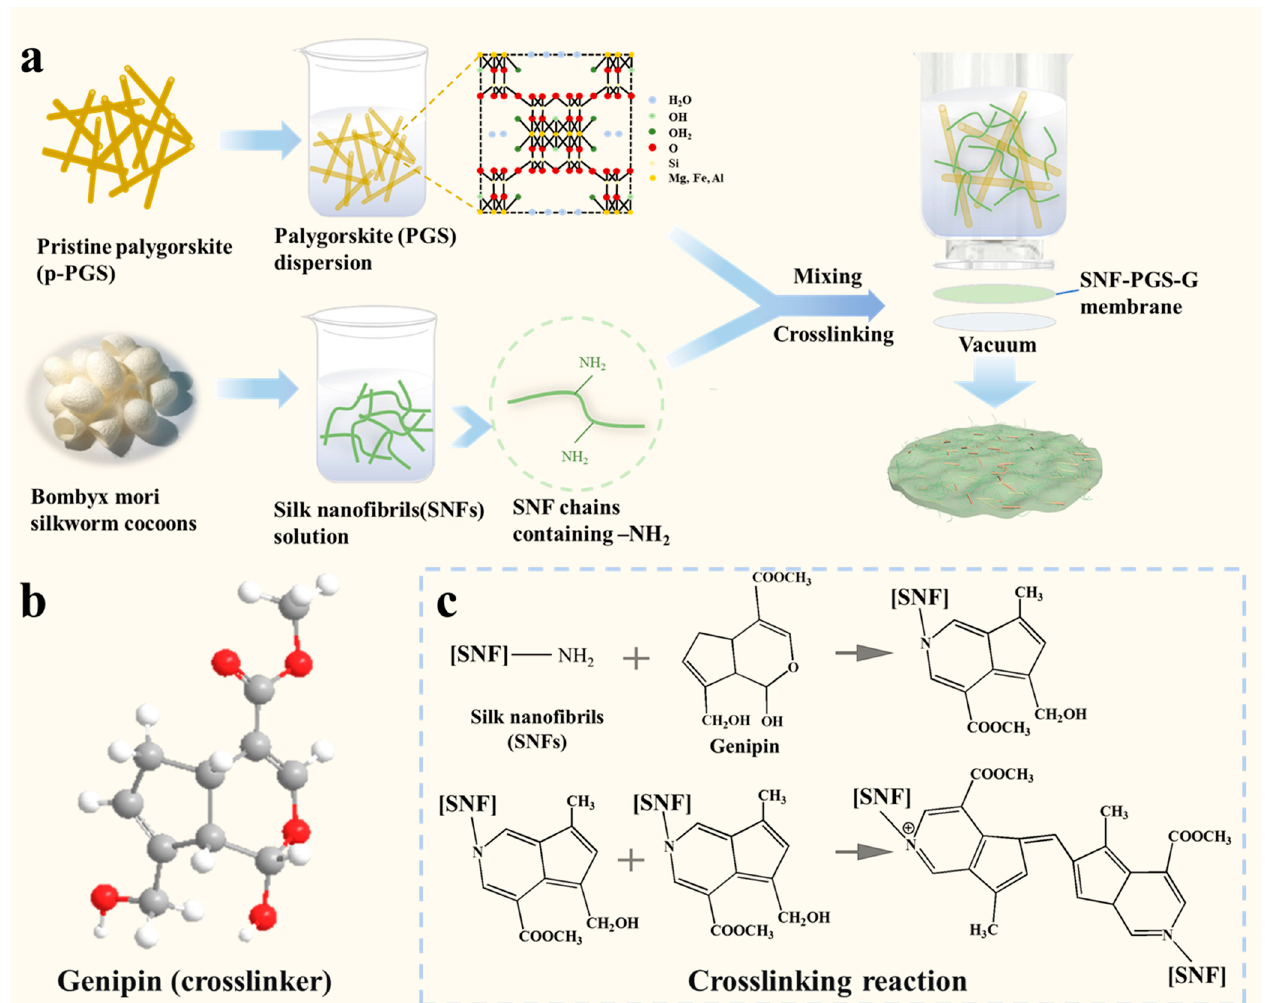
Figure 1. Preparation technology and crosslinking mechanism of mixed dimensional SNF-PGS-G composite membrane: ( a ) schematic diagram of composite membrane preparation; ( b ) structural formula of genipin; ( c ) crosslinking mechanism of SNF and genipin. Reprinted with permission from Ref. [30].